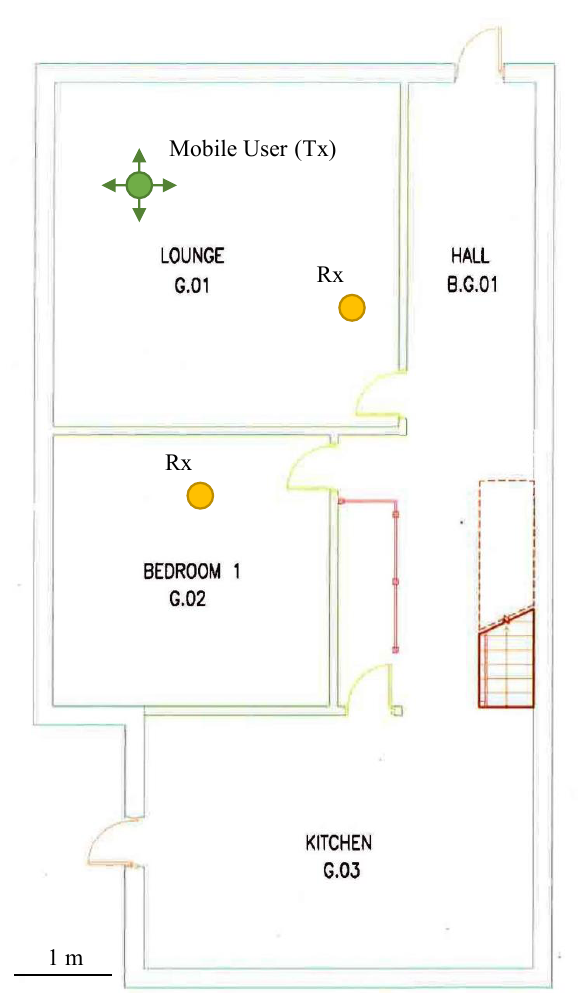
Figure 14. The floor plan of the SPHERE house. Two receiver units are deployed in the lounge and the bedroom. SPW-2 is mounted on the wrist of a user who is performing random walks and activities in the lounge.